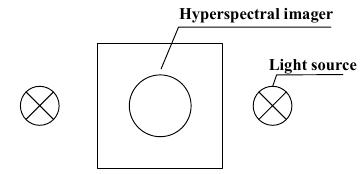
Figure 1. The position of the light source and imager